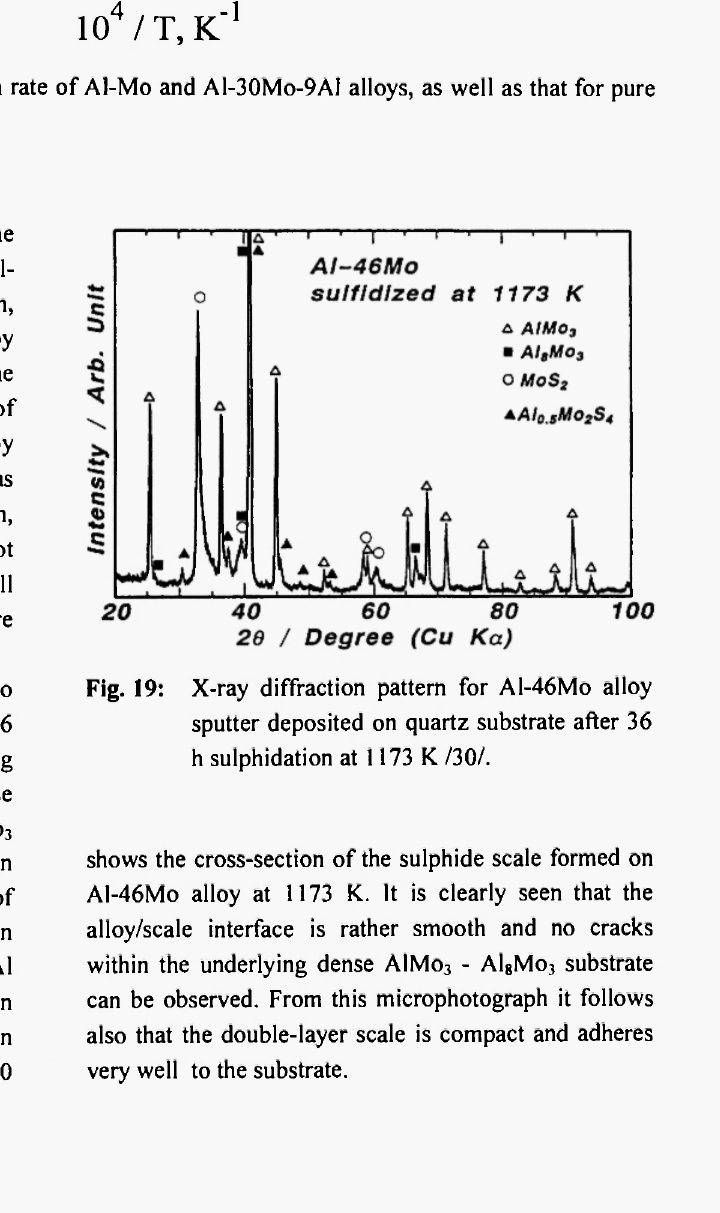
Fig. 18: Temperature dependence of the sulphidation rate of Al-Mo and Al-30Mo-9AI alloys, as well as that for pure molybdenum.